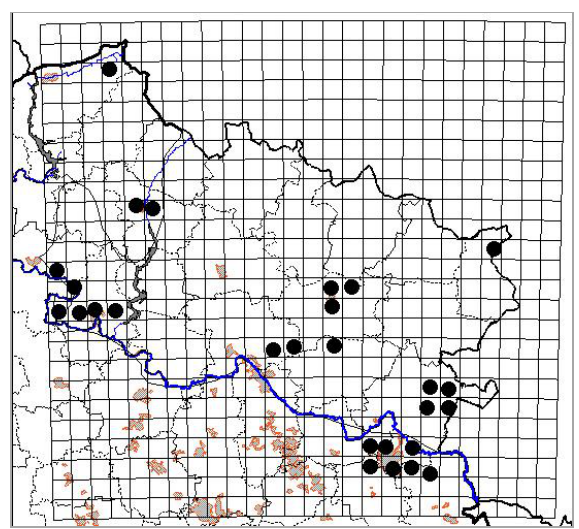
Fig. 16. The map of the distribution of Cyclachaena xanthiifolia (Nutt.) Fresen. in the Starobilsk grass-meadow steppe